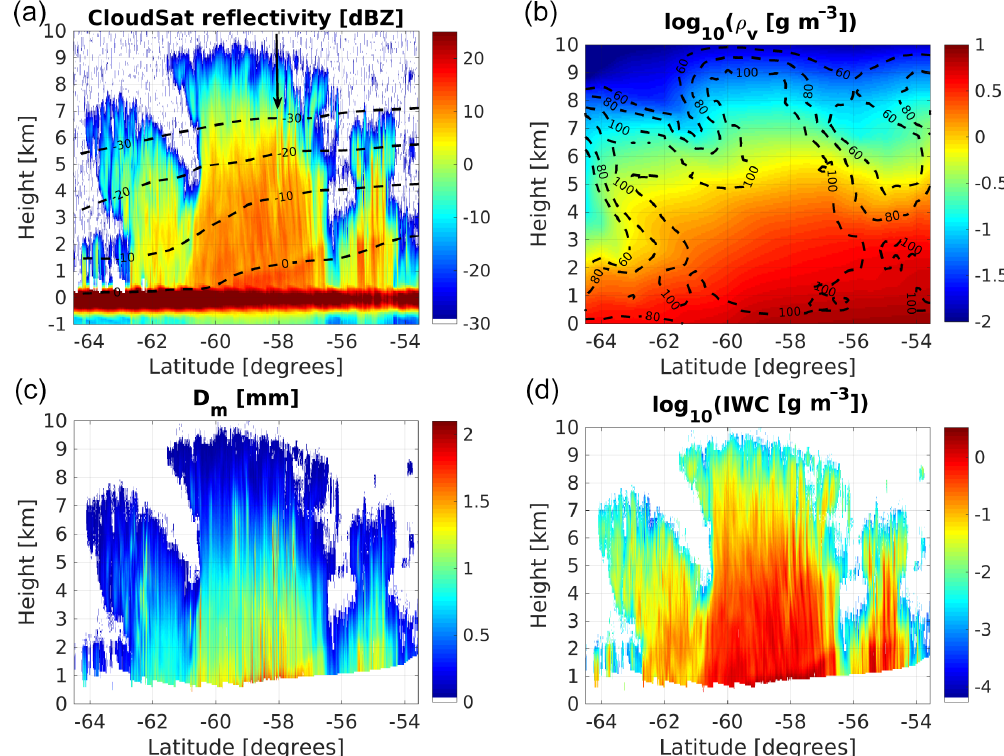
Figure 3. (a) CloudSat measured reflectivity in the Southern Ocean southwest of Cape Horn. Dashed black lines correspond to different isotherms as labelled, while the black arrow corresponds to the profile analysed in Fig. 5. (b) Water vapour density as derived from ECMWF reanalysis with regions of constant relative humidity with respect to ice depicted as dashed lines. (c, d) Mean mass-weighted diameter of ice particle (c) and ice water content (d) as retrieved by the DARDAR